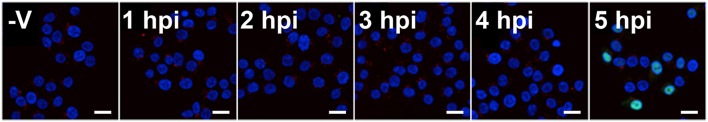
The fluorescence images of the immunostaining of non-infected cells (–V) and virus-infected cells from 1 to 5 h post-infection (hpi) (Blue: nucleus; Red: nanoprobes, Green: PB1 viral protein). Scale Bar: 20 μm.